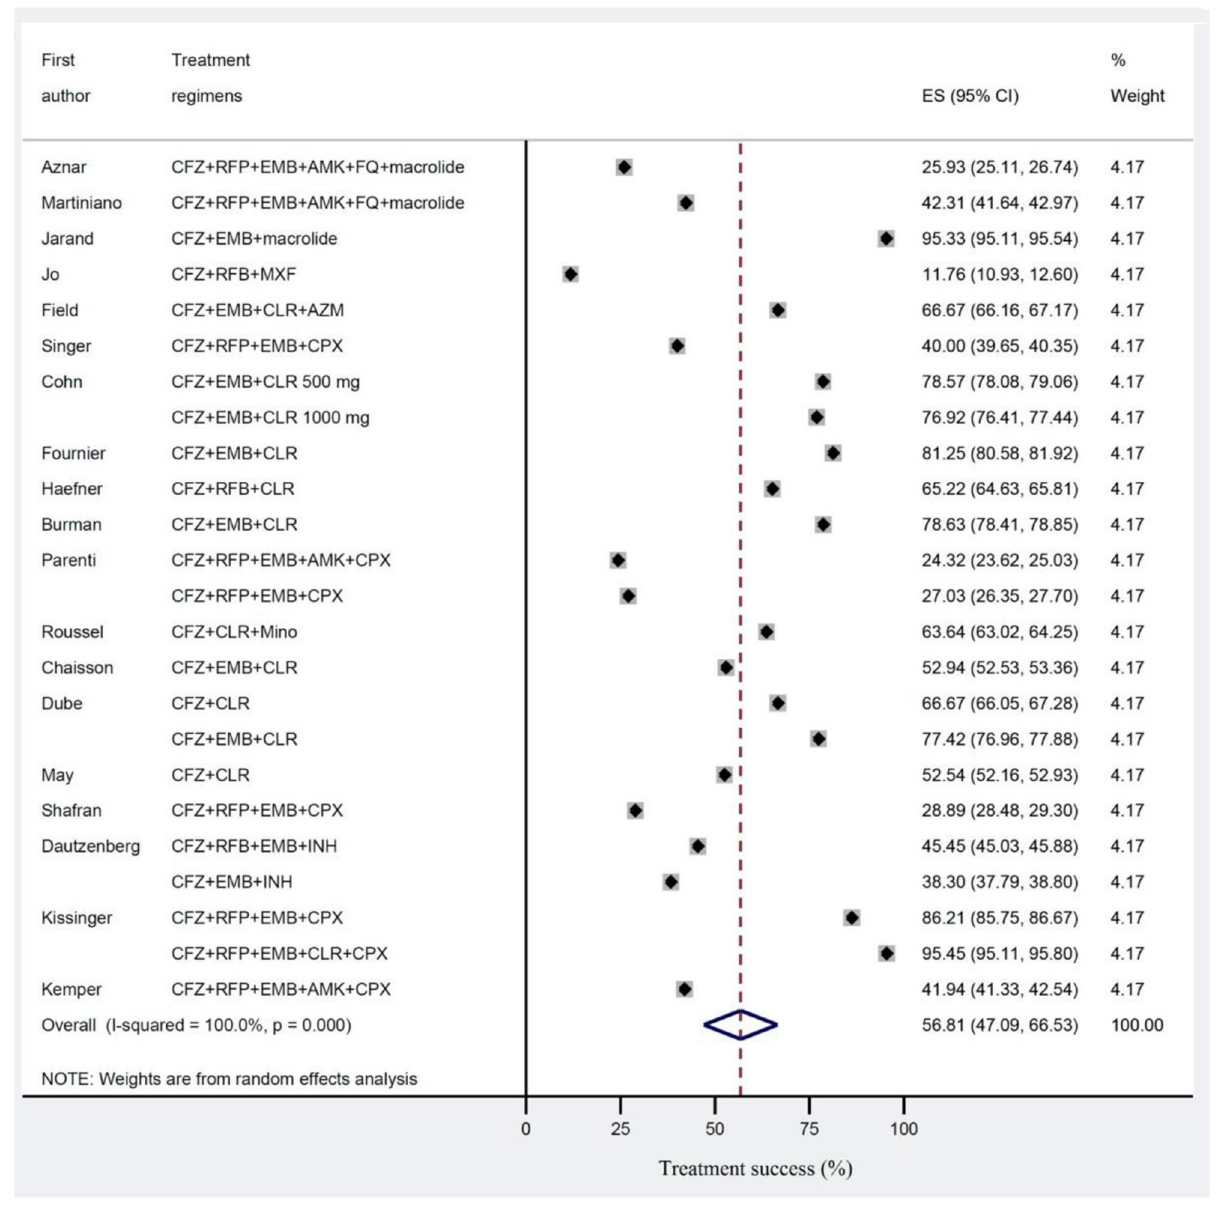
FIGURE 2 | Treatment success for Mycobacterium avium complex (MAC) disease in studies with clofazimine in their regimens. Treatment effects and summaries were calculated using a random-effects model weighted by study